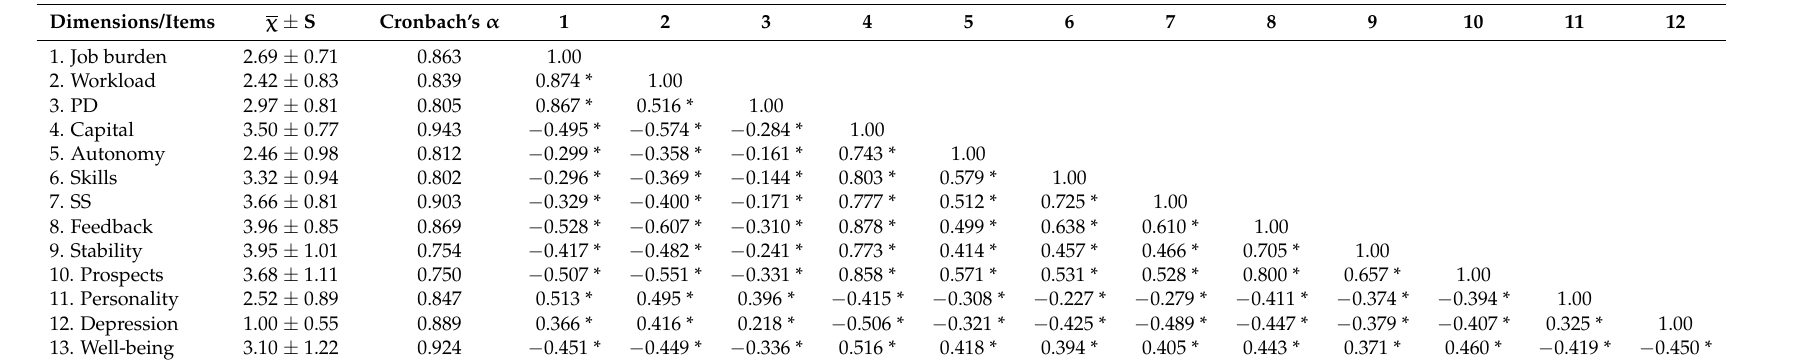
Table 1. Analysis of correlation and internal consistency of each